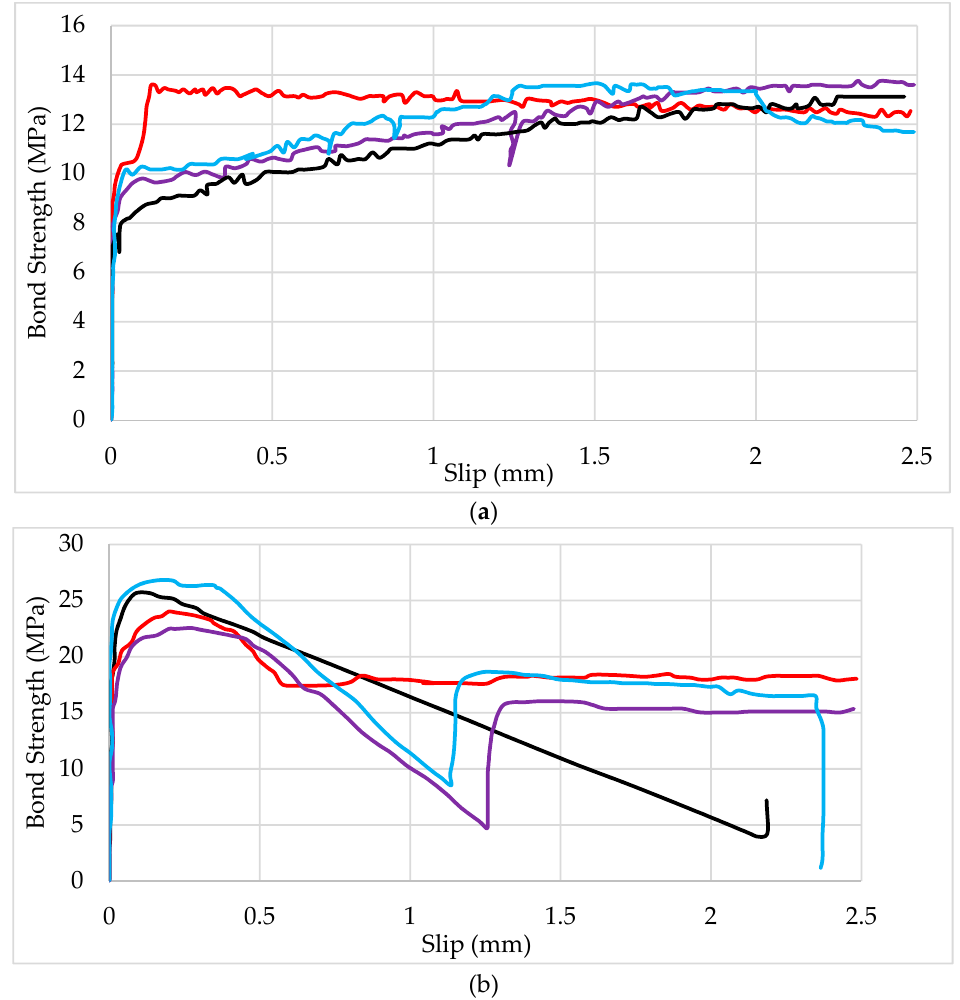
Figure 5. Bond strength–slip relationship for 10-mm diameter wrapped samples (each color is different sample) BFRP bars with ( a ) primary sand coating, ( b ) secondary sand coating. Reprinted with permission from ref. [27]. Copyright 2021 Elsevier Science & Technology Journals.